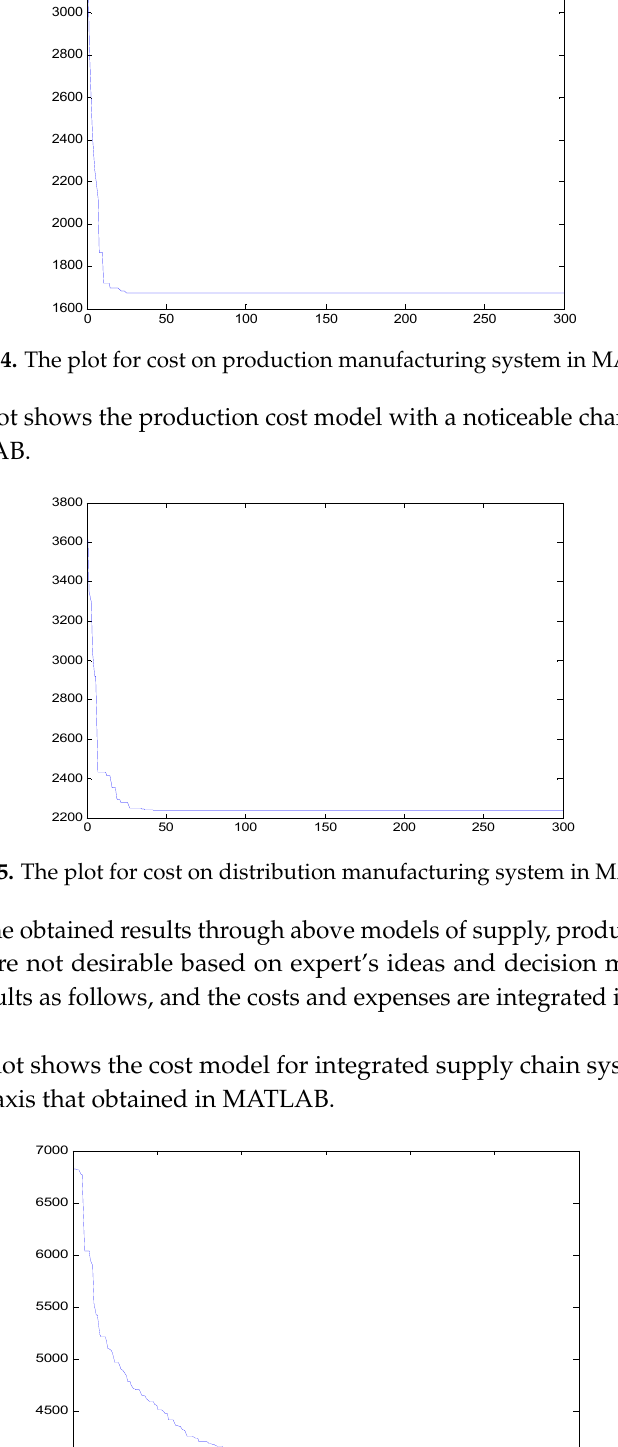
Figure 6. The plot for Total cost of integrated manufacturing function in MATLAB. The last results confirms that the integrated costs model is the optimum solution in comparison with the total cost of three models supply, production and distribution through the certain time periods of 1, 2, 3 and 4.